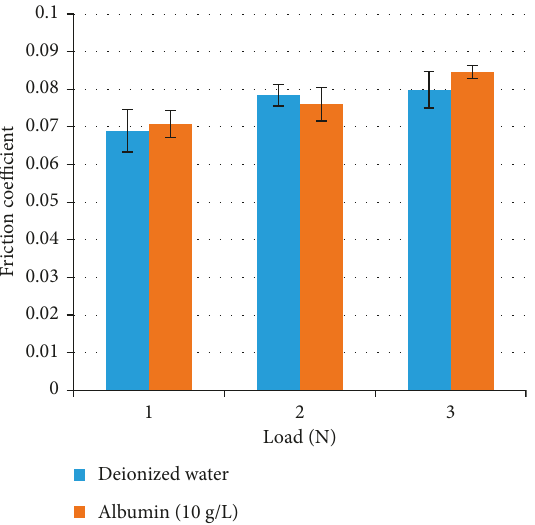
Figure 8: Effect of lubrication condition at a speed of 1Hz.